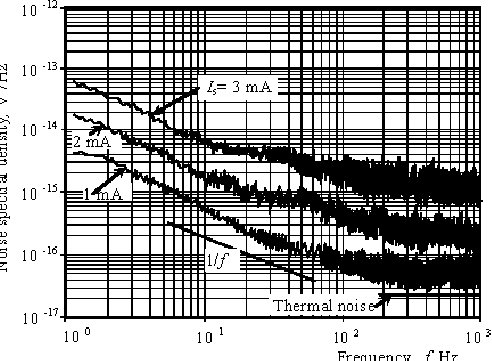
Figure 3. Spectral density of internal noise V C1,4 (0), the supply current I s is as a parameter, T = 20